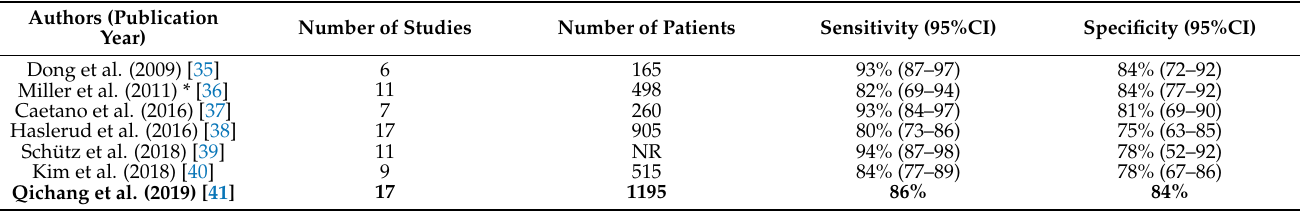
Table 3. Diagnostic performance of 18 F FDG PET/CT in DTC restaging according to published meta-analyses (adapted from Piccardo A et al. Rev Endocr Metab Disord. 2019)